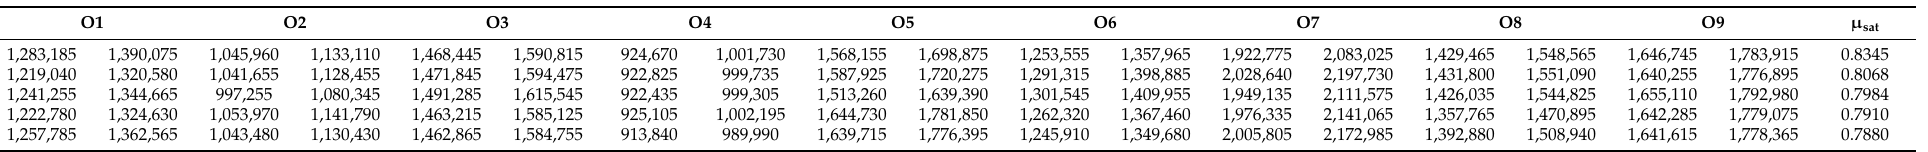
Table 4. Best ranked solutions to Problem 1 with N sat = 10 and N dis = 0 (after the consensus round).